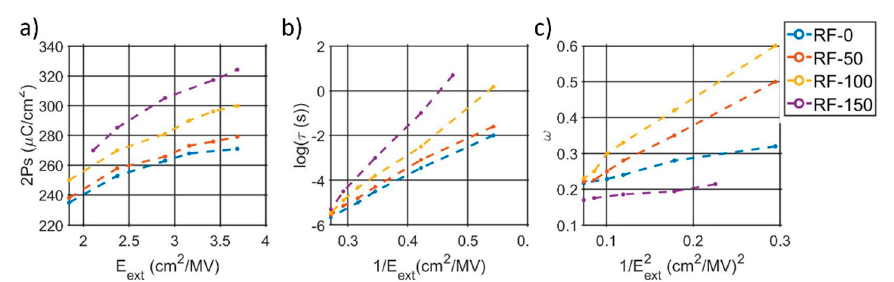
Figure 8. Summary of the extracted NSL model parameters: ( a ) switching polarization per different applied electric fields during the write signal, ( b ) average activation time versus the inverse of the applied field, and ( c ) relation between ω and the inverse of the square of the